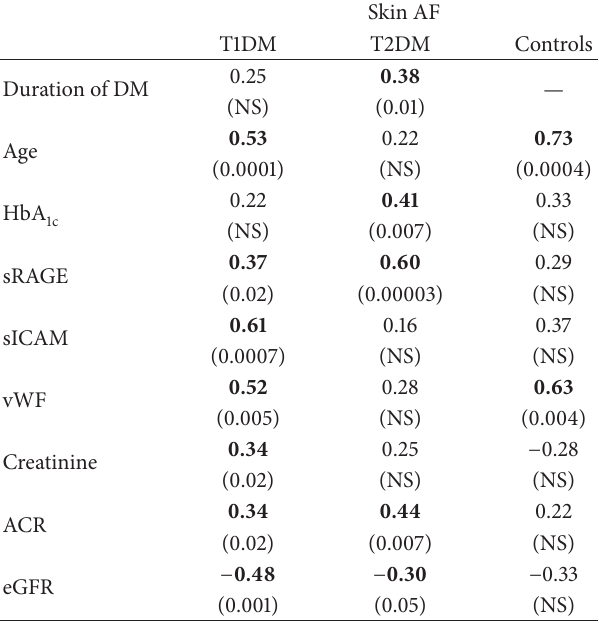
Table 4: The univariate significant correlations between skin aut- ofluorescence and biochemical